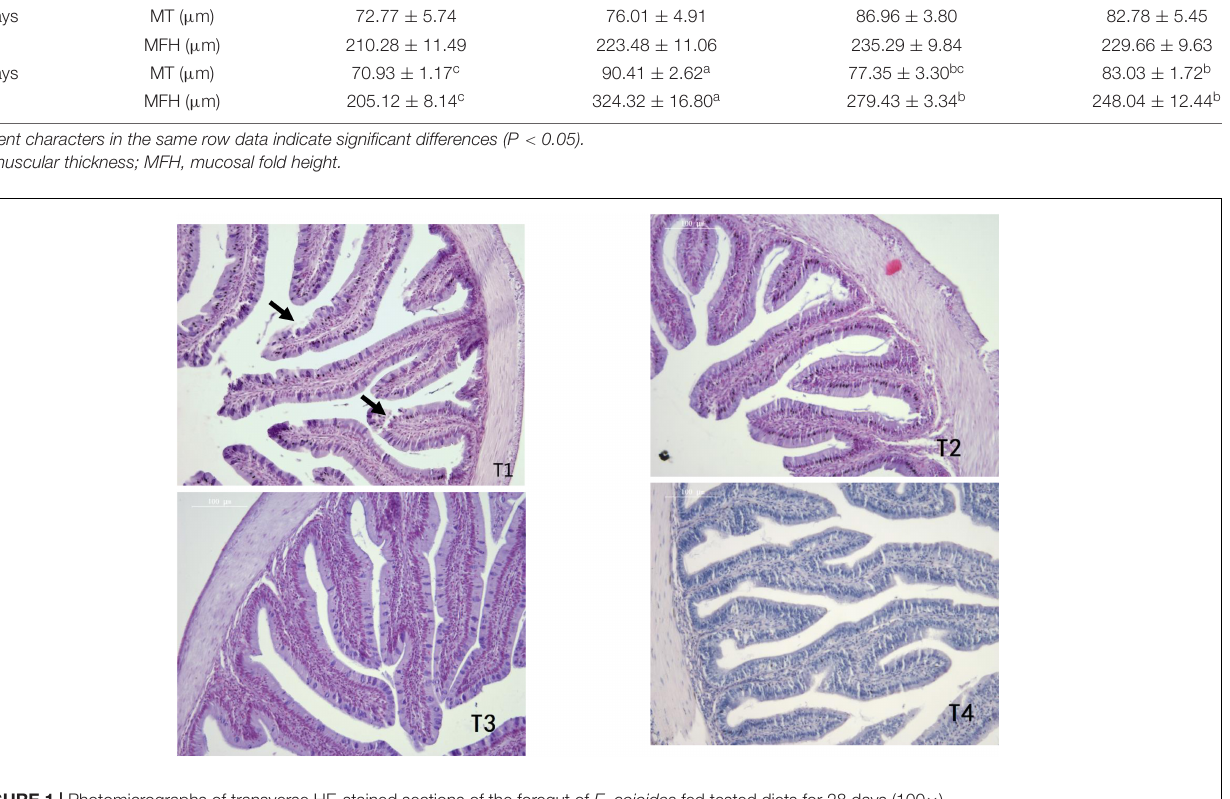
FIGURE 1 | Photomicrographs of transverse HE-stained sections of the foregut of E. coioides fed tested diets for 28 days (100 ×